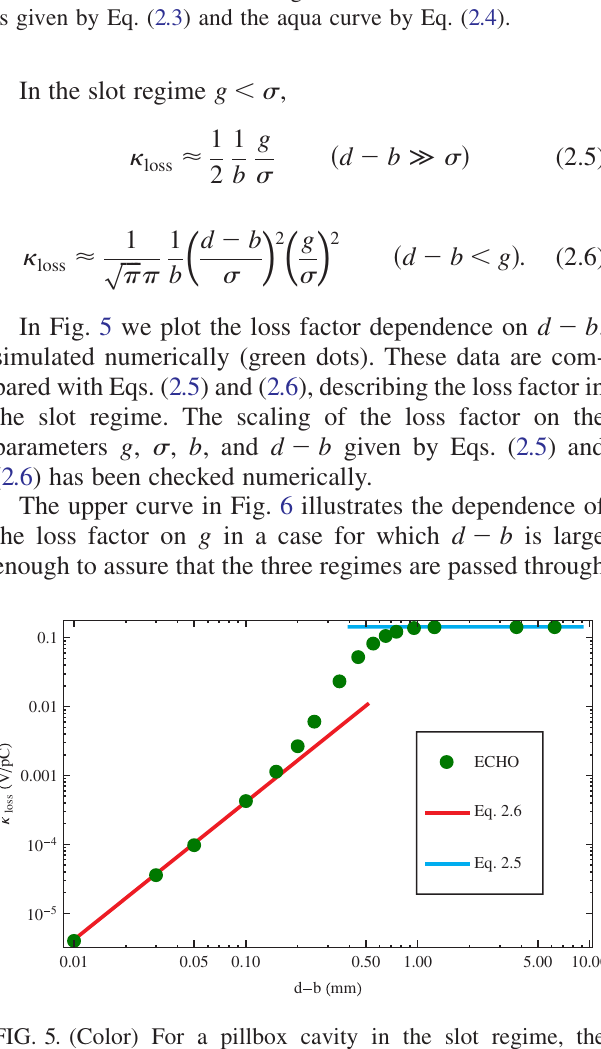
FIG. 4. (Color) For a pillbox cavity in the cavity regime, the dependence of the loss factor on d (cid:2) b is shown for (cid:1) ¼ 0 : 5 mm , b ¼ 6 : 25 mm , and g ¼ 10 mm . The dots represent the results of calculations using the ECHO code. The red curve is given by Eq. (2.3) and the aqua curve by Eq. (2.4).